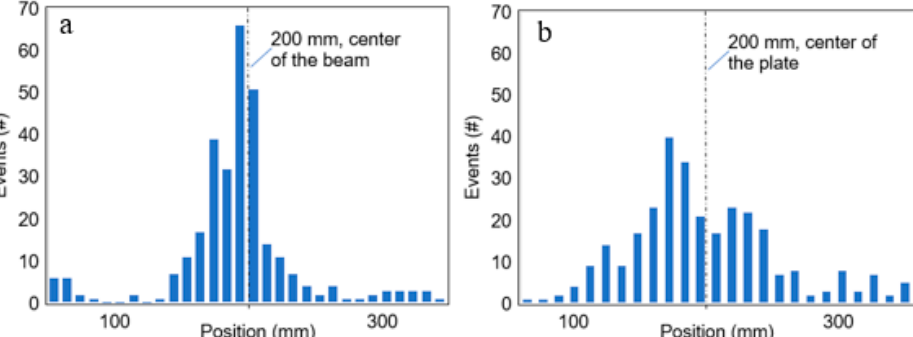
Figure 11. AE signals attributed to cracking from plate (left) and beam (right).